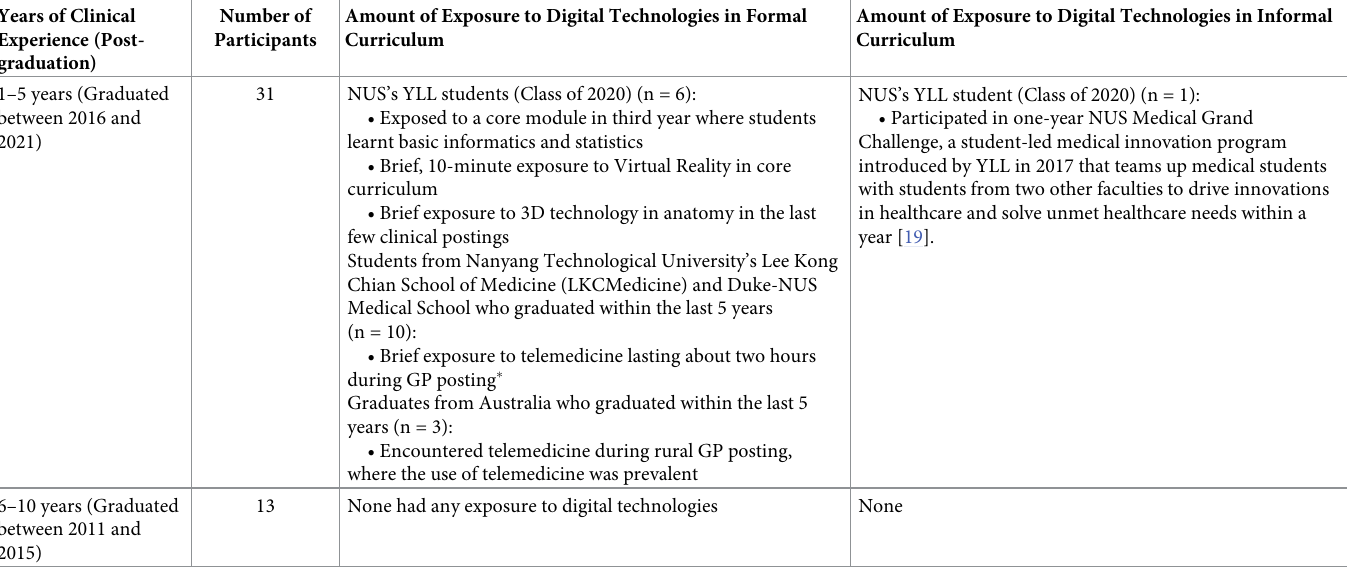
Table 2. Summary of respondents’ reported exposure to digital technologies in the medical school